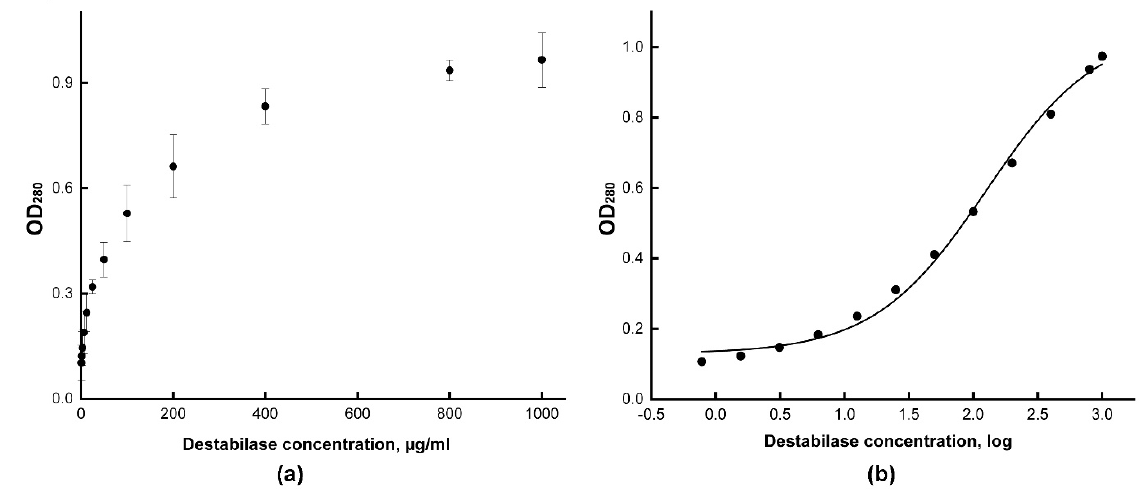
Figure 2. Blood clot destabilization with various destabilase concentrations. We measured the optical density at 280 nm of a clot products solution after dissolution in 2% acetic acid. The clots were pretreated with various destabilase concentrations from 0.7 μ g/mL to 1000 μ g/mL. The OD 280 values are expressed as mean ± standard deviation ( a ). To determine the working concentration of destabilase, the dose–response sigmoid curve was plotted ( b ). The EC 50 and EC 80 concentrations were defined.